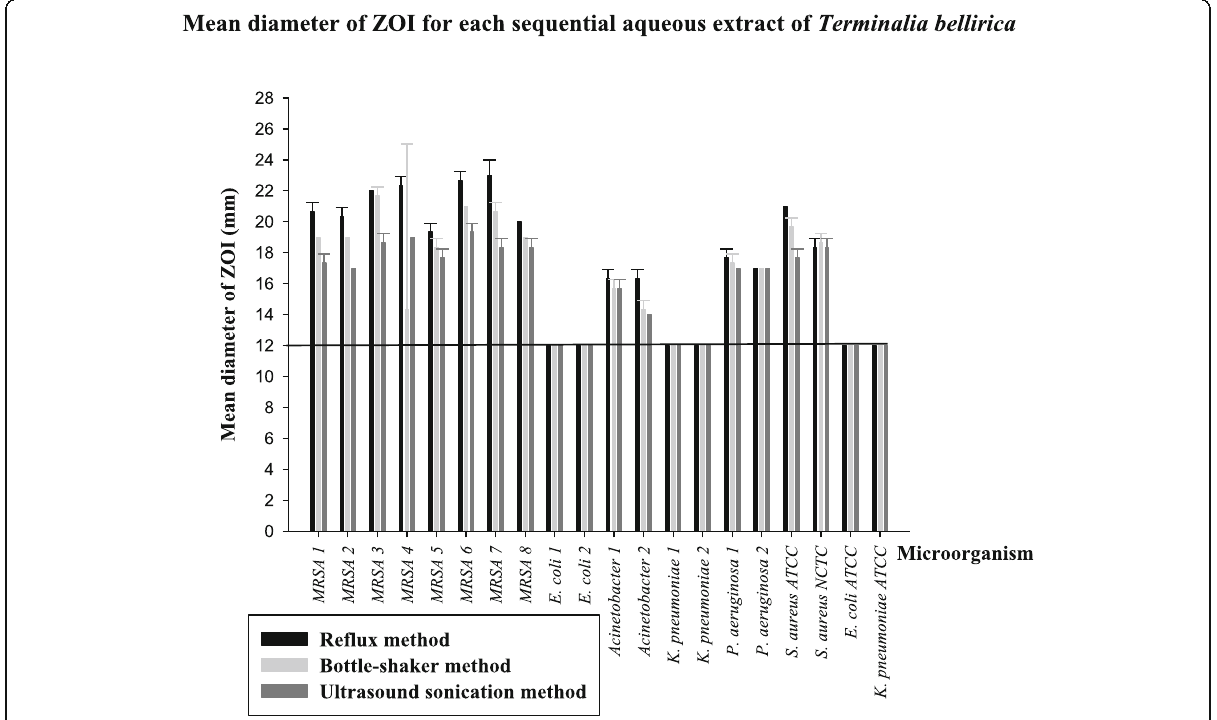
Fig. 4 Mean diameter of zones of inhibition (ZOI) for sequential aqueous extracts (10 mg/mL) of Terminalia bellirica prepared from reflux method, bottle-shaker method and ultrasound sonication method